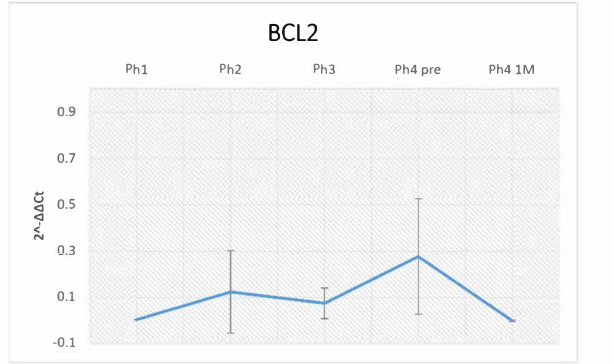
Figure 4. The qRT − PCR analysis of human fetal and postnatal kidneys using primers for CRKL, UBASH3A, AIFM3, AIF, and BCL2 and their calculated 2 - ∆∆ Ct .